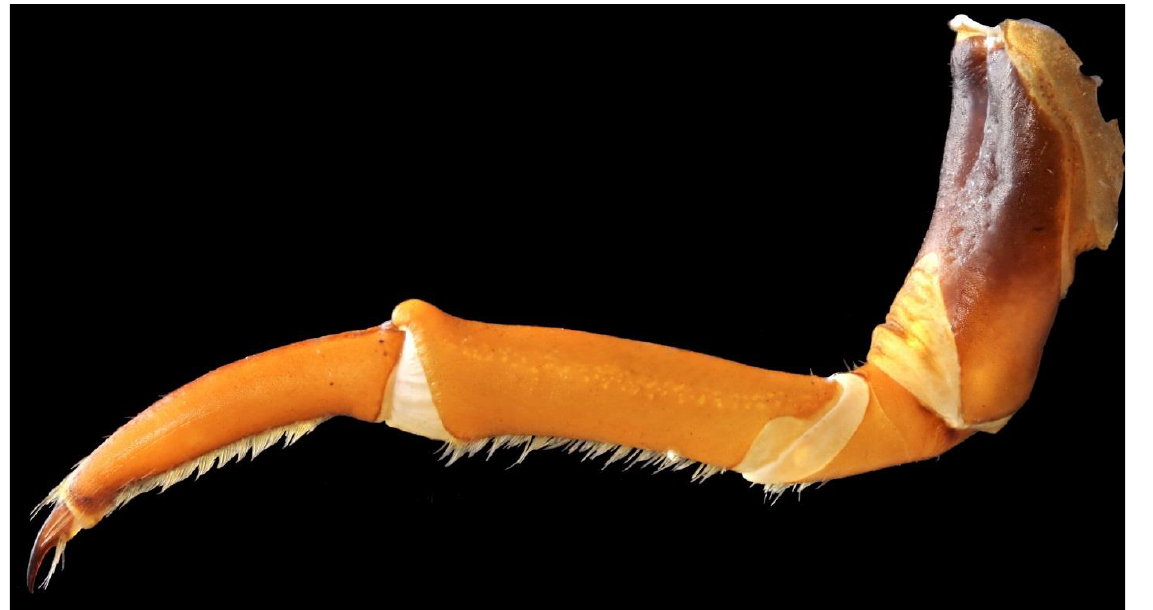
Figure 4. Platerodrilus svetae , female larva, mesoleg.